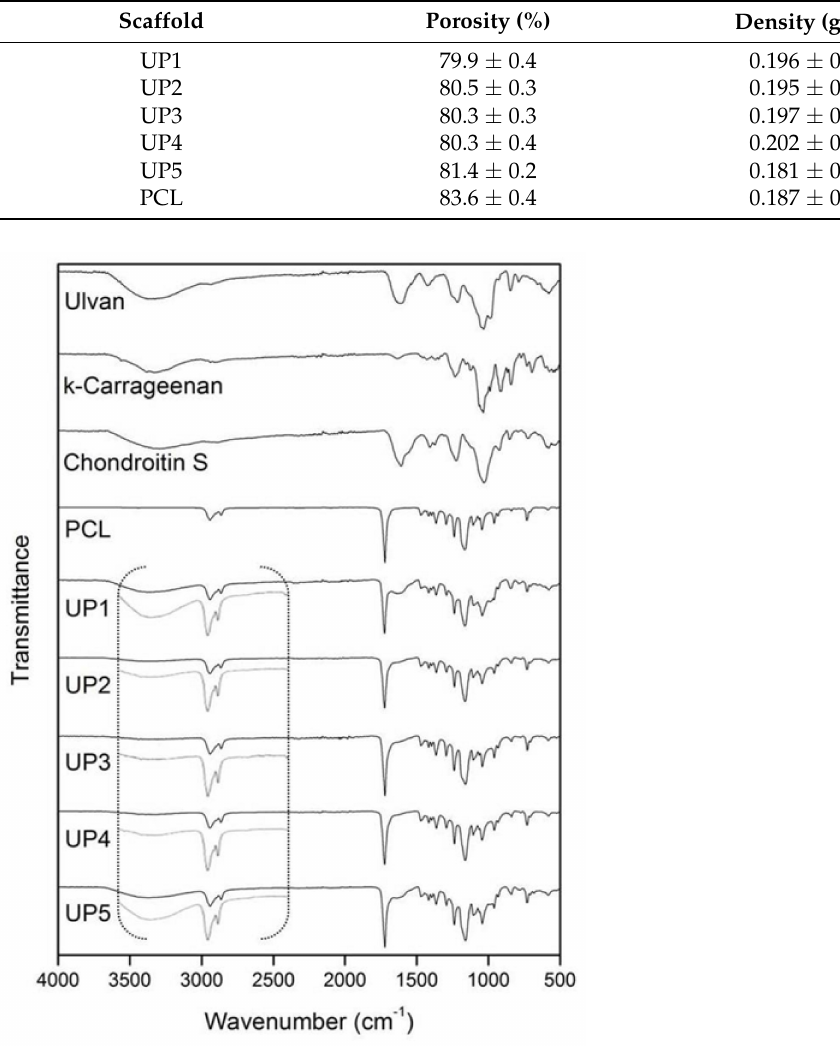
Table 1. Mean values and standard deviations of porosity and density of UP scaffolds ( n = 6).